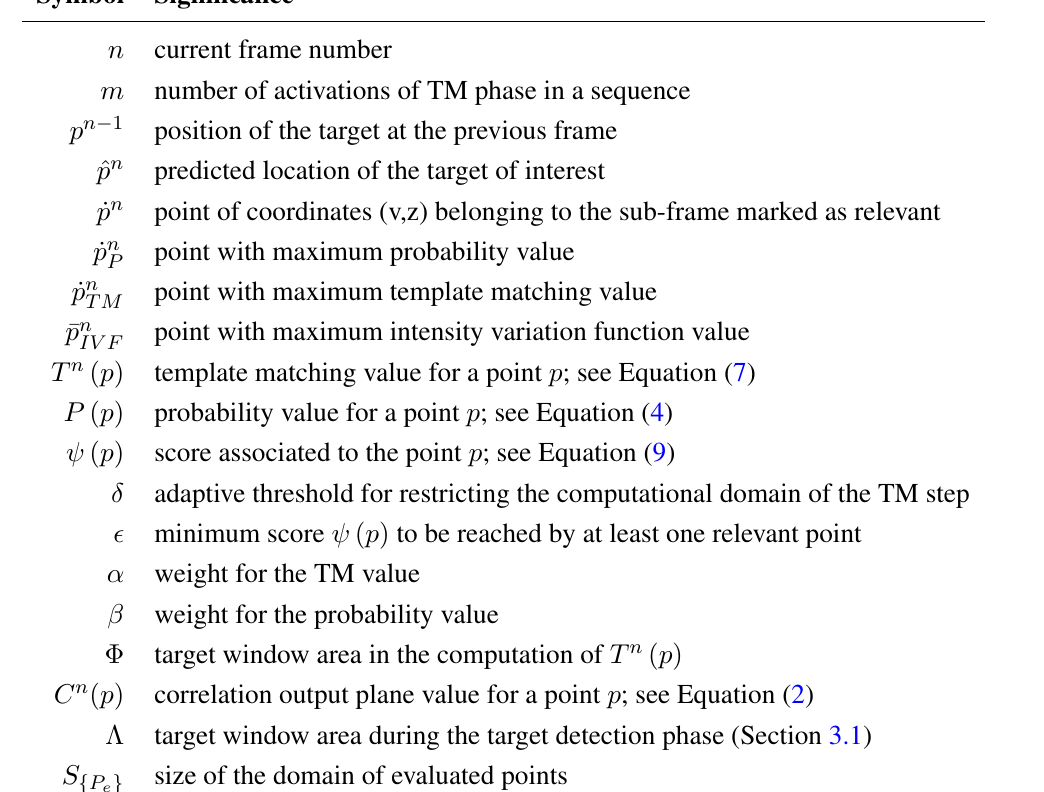
Table 1. List of